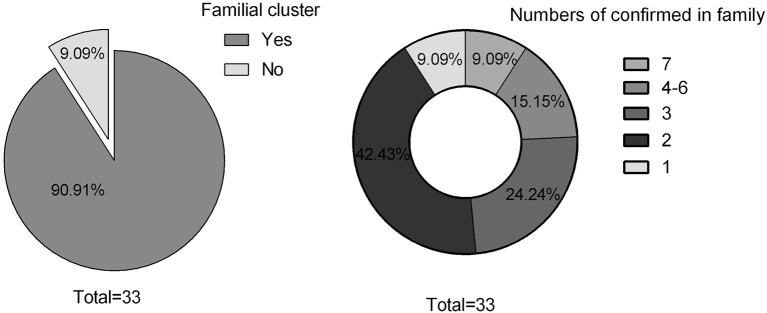
Familial cluster.